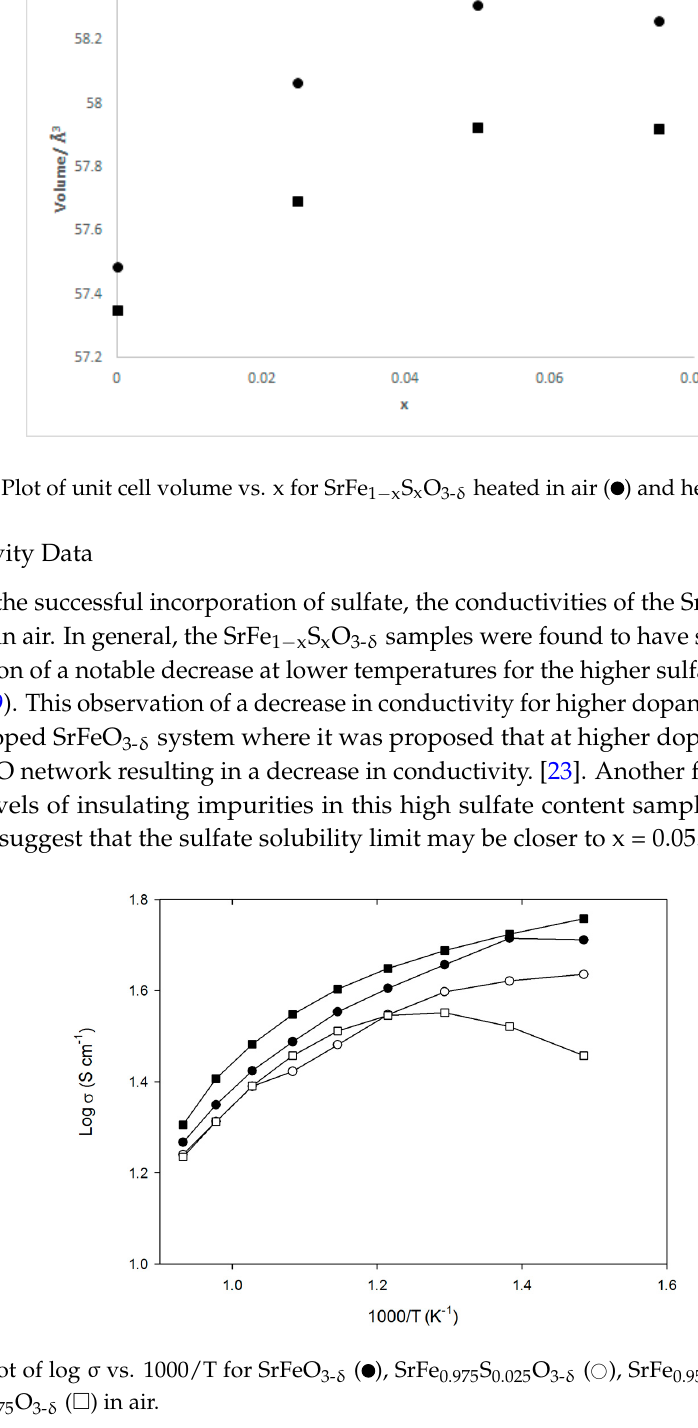
), SrFe 0.95 S 0.05 O 3- δ ( (cid:4) ) and